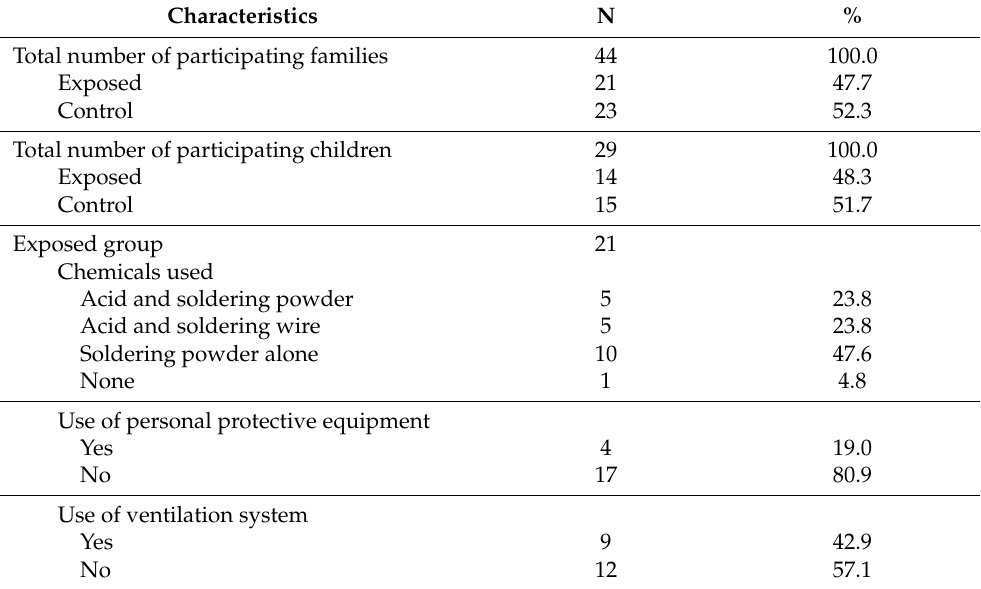
Table 1. Distribution of demographic characteristics and working conditions of study population by group. Limeira, Brazil,